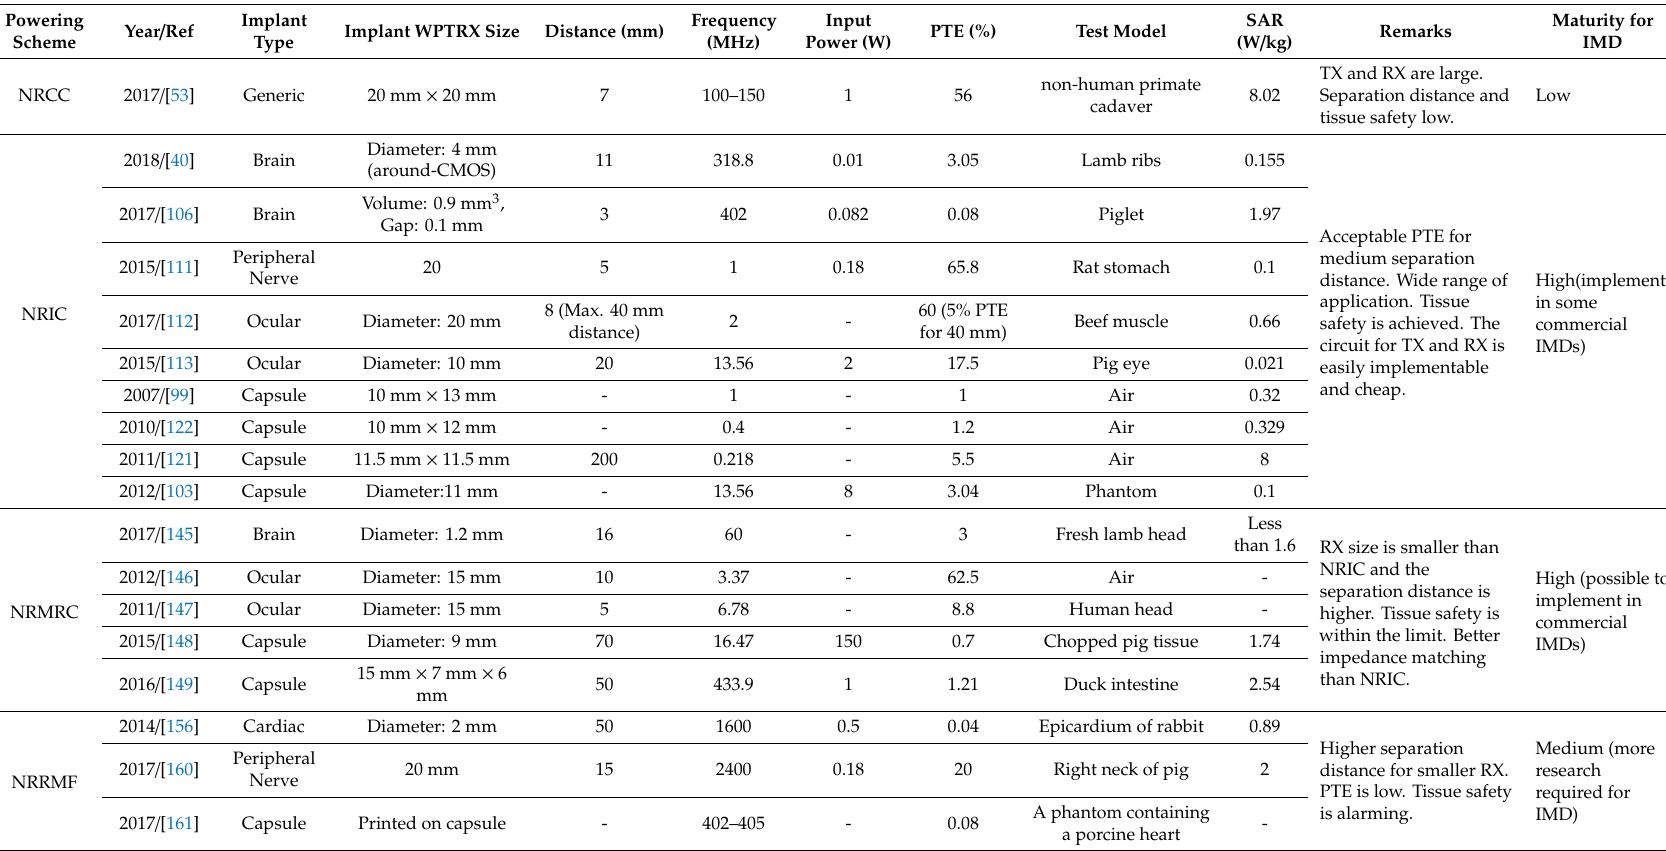
Table 2. A comparison of di ff erent WPT techniques for IMD applications includes power budget, PTE and SAR to allow the reader decide particular technique of